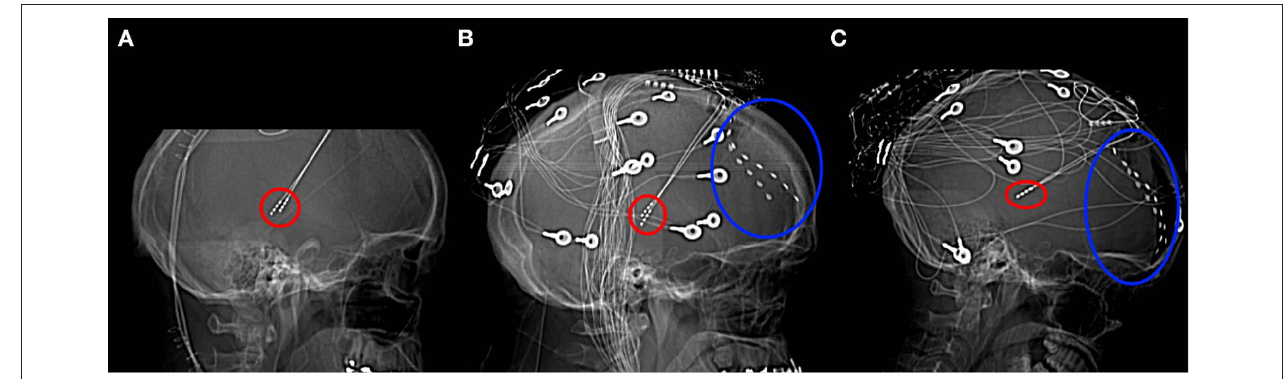
FIGURE 2 | Top row: Proportion of channels showing significant local PAC in the thalamus (Subject 1 left, Subject 2 middle, Subject 3 right). Bottom row: Mean strength of PAC (assessed with the normalized modulation index) in the thalamus (Subject 1 left, Subject 2 middle, Subject 3 right).